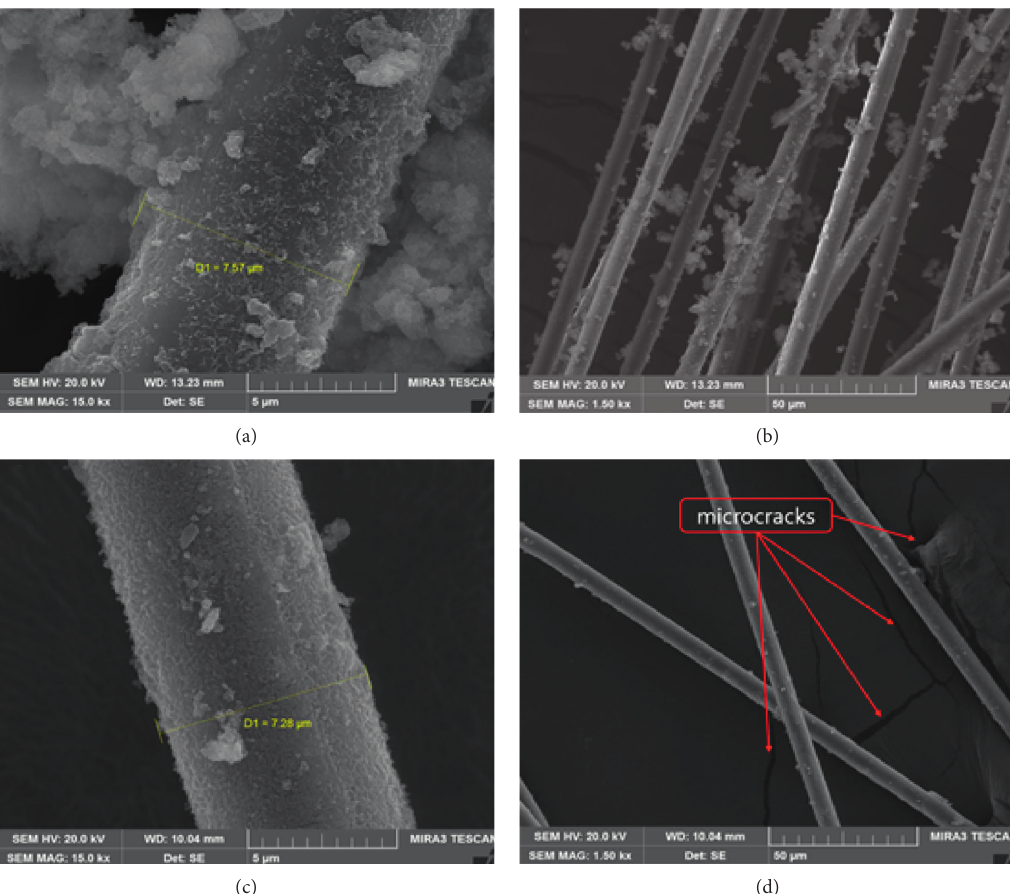
Figure 13: SEM images of the carbon fiber in the cement paste matrix after the pull-out test (15,000 or 1,500x). (a, b) Nano-SiO carbon fiber with 10 wt.% SF. (c, d) Nano-SiO 2 -coated carbon fiber without